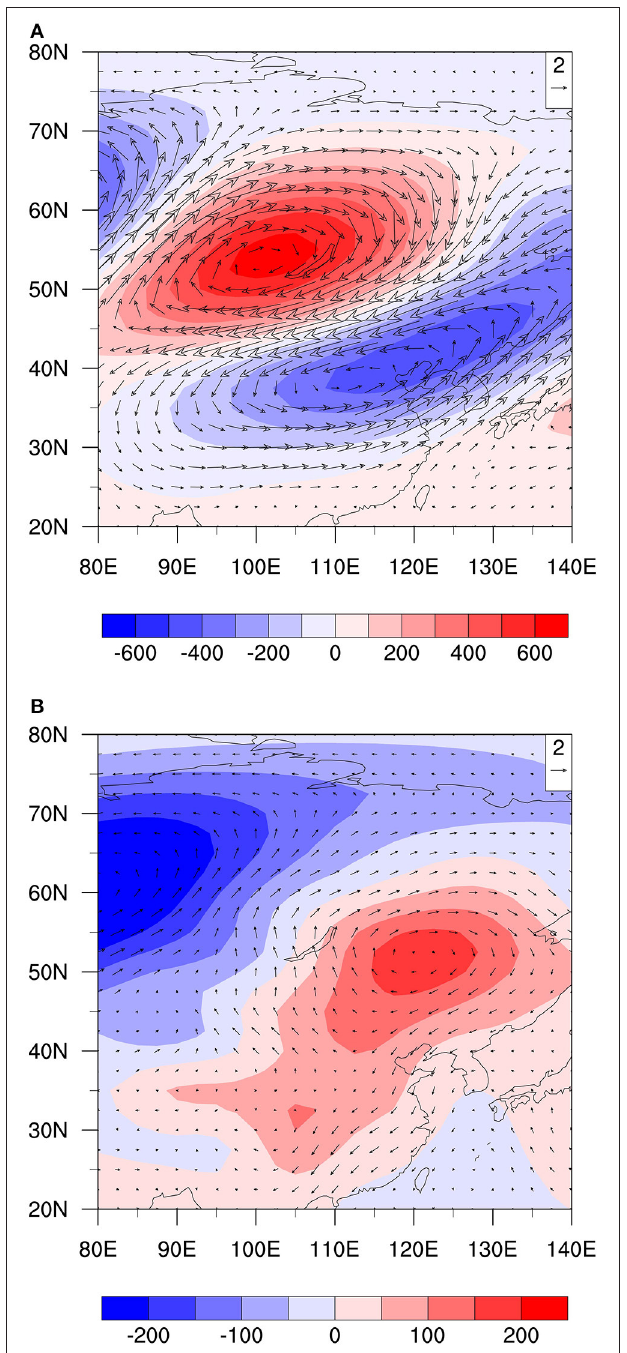
FIGURE 10 | The composite intraseasonal wind field (vector, unit: m s − 1 ) and geopotential height field (shading, unit: gpm) at 250 hPa (A) and 850 hPa (B) at day − 3.